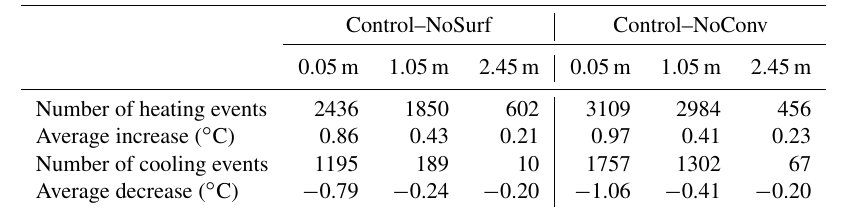
Table 2. The numbers of occurrences of heating and cooling CHT events and the average temperature deviations caused by CHT at 0.05, 1.05, and 2.45m depths at TGL. The deviations of 0.1 ◦ C or less were excluded for statistics.